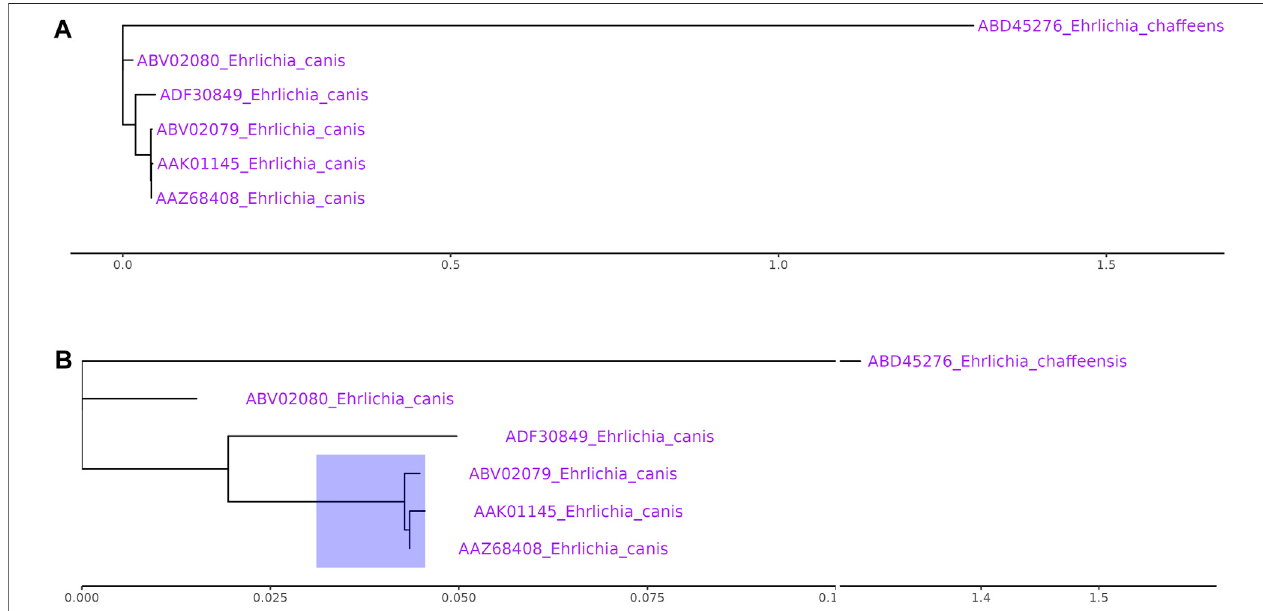
FIGURE 2 | Phylogenetic tree with outlier long branch. (A) The original plot fails to present the detailed topological structure of the main group. (B) The tree with a gapped axis to shrank the outlier long branch improves the readability of the main group. All sequences were collected from NCBI database ( Ehrlichia chaffeens : ABD45276; Ehrlichia canis :ABV02080, ADF30849, ABV02079, AAK01145, AAZ68408).